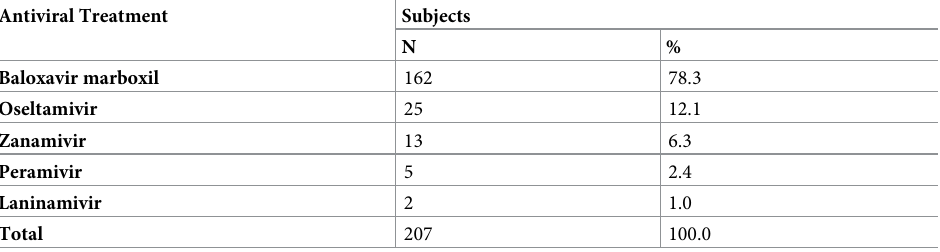
Table 4. Antiviral influenza medications administered for all patients with both a valid Liat test and RADT